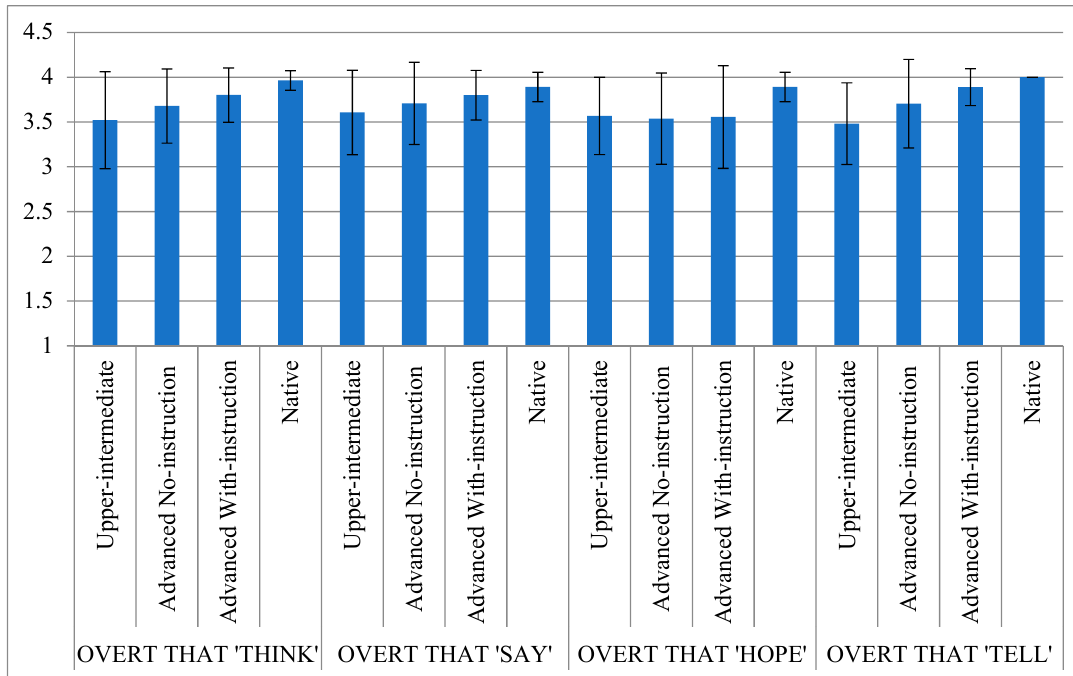
Figure 2. Acceptability rates by group and verb. Null that condition.